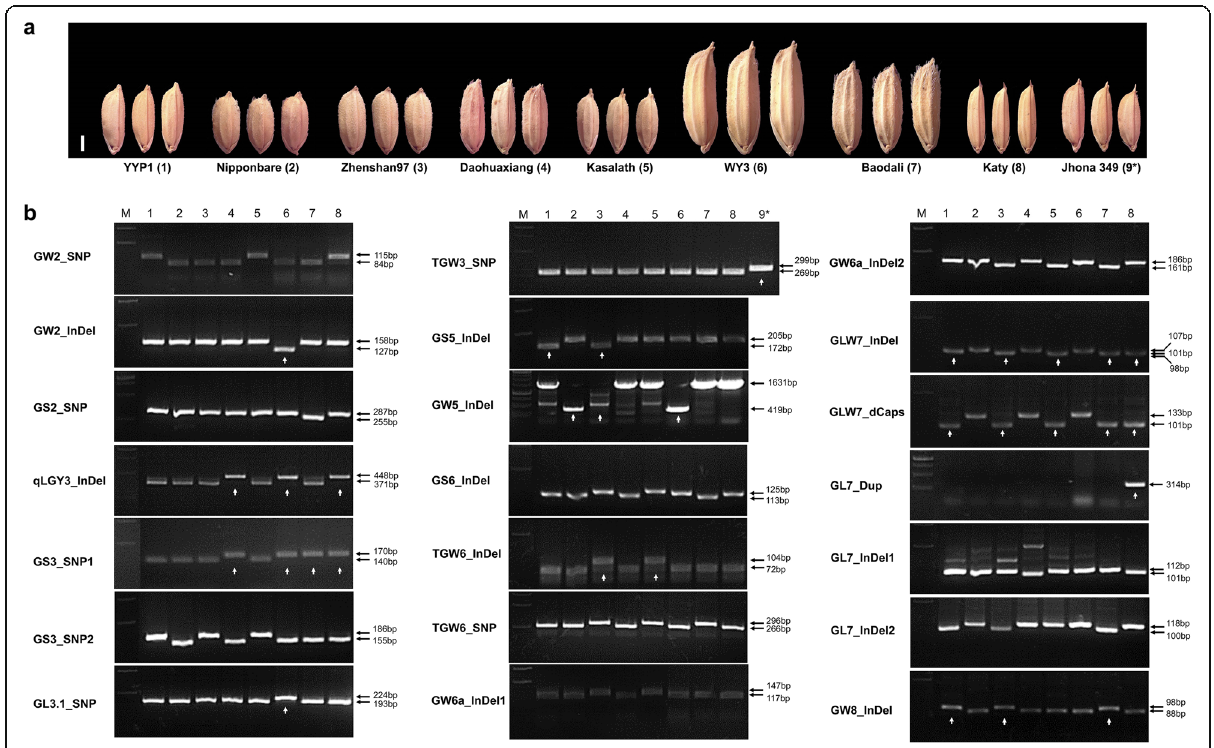
Fig. 2 Evaluation of the marker set by PCR-gel-based analysis. a. View of grain size of nine cultivars for marker evaluation. Scale bar, 2 mm. * denotes the cultivar only for allele discrimination of the TGW3_SNP marker. b. Agarose gel images of 21 markers. The band size in bp of the different alleles is labeled on the right side (black arrow), and the superior alleles for wider or longer grains are identified by white arrows. (M identifies the DNA